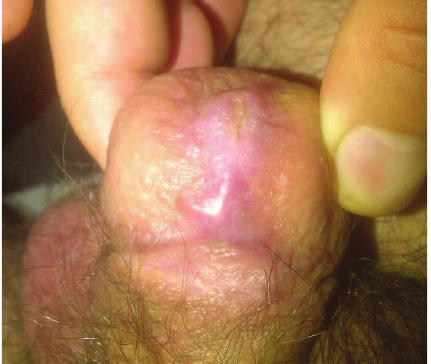
Figure 8: Glans at six weeks